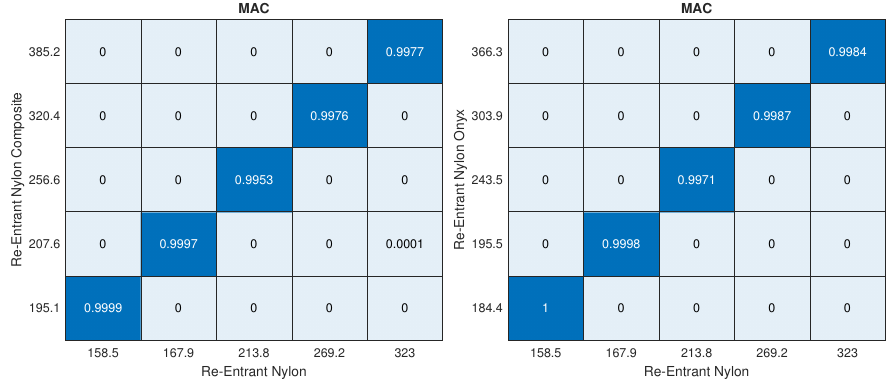
Figure 10. MAC analysis’ result of re-entrant lattice structure: